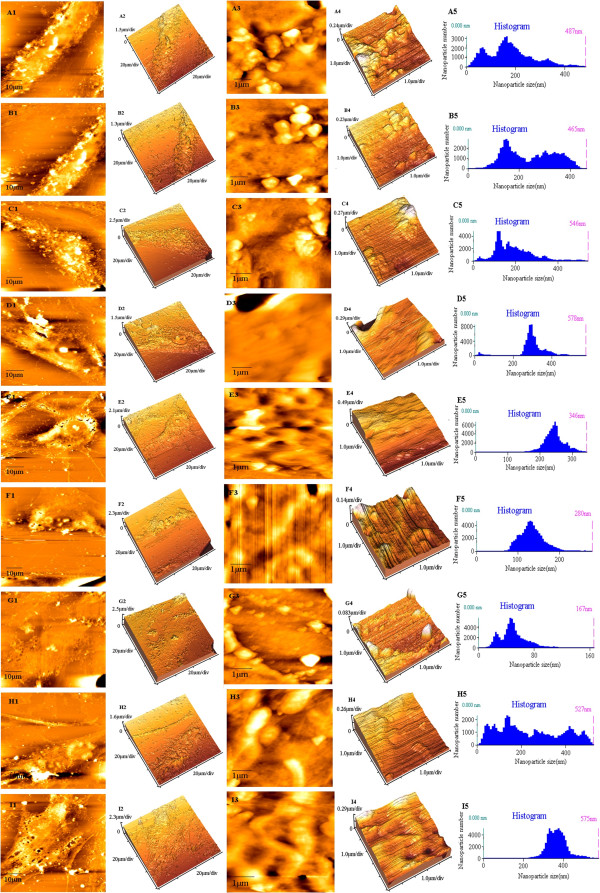
AFM images of the nine groups. AFM images of ADS (A1-A5), 3DD (B1-B5), 6DD (C1-C5), 9DD (D1-D5), 12DD (E1-E5), 15DD (F1-F5), 18DD (G1-G5), 21DD (H1-H5) and NC (I1-I5). (A1-I1) AFM images (scanning area 70 × 70 μm2); (A2-I2) 3D images; (A3-I3) nanostructural images (scanning area 5 × 5 μm2); (A4-I4) 3D images of nanostructure; (A5-I5) histograms of the particles size extracted from images A4-I4, respectively.